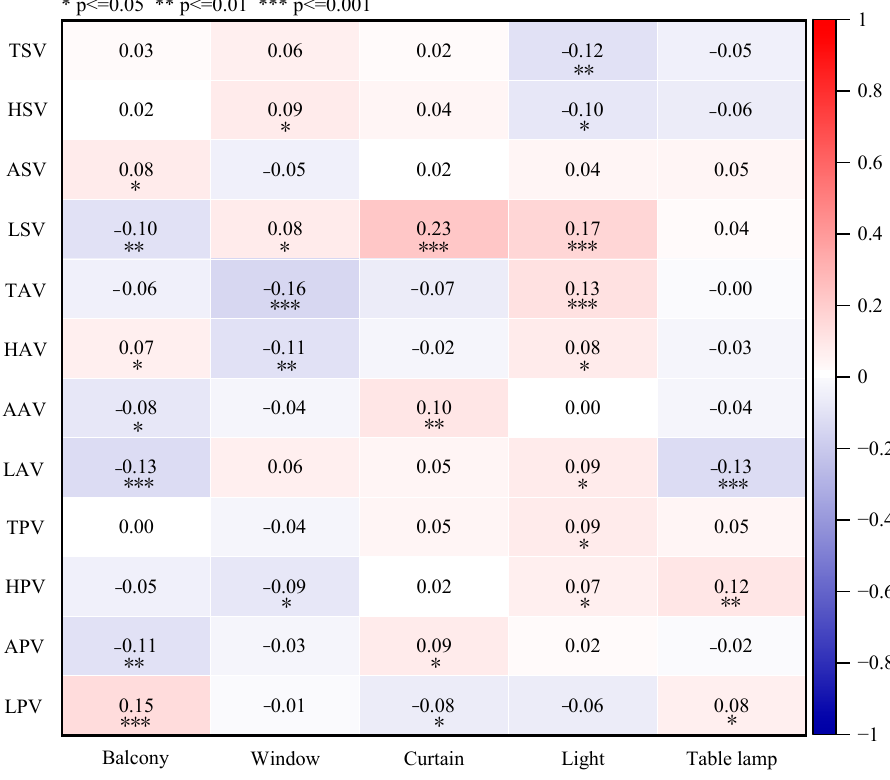
Figure 6. Results of the correlation analysis between the individual environmental adjusting behavior and environmental perception.